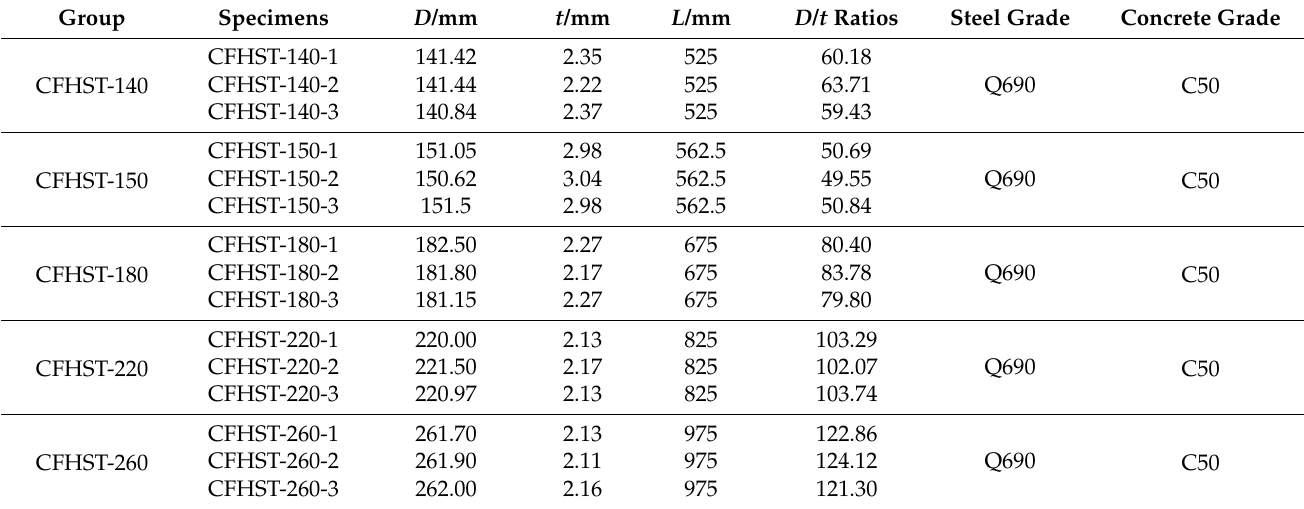
Table 1. Designed parameters of CFHST stub